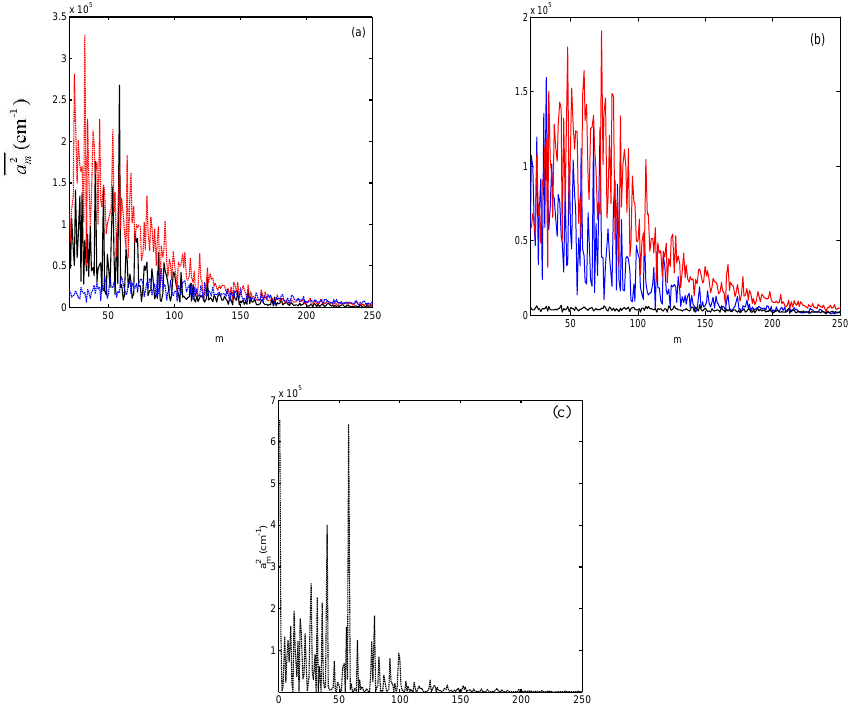
Figure 2. Spectral characteristics of coherent structures observed off California. (a) and (b) : time-averaged energy density ( a 2 m ) vs. mode number for the six frequency bands used in this study. (a) Black, red and blue correspond to quasi-zonal jets (with scales longer than 36 months), annual Rossby waves (with scales from 8 to 18 months), and mesoscale eddies (with scales from 2 to 4 months). (b) Blue, red and black correspond to biannual oscillations (with scales from 18 to 36 months), semiannual Rossby waves (with scales from 4 to 8 months), and mesoscale eddies (with scales from 1 to 2 months). (c) An instantaneous spectrum a 2 m